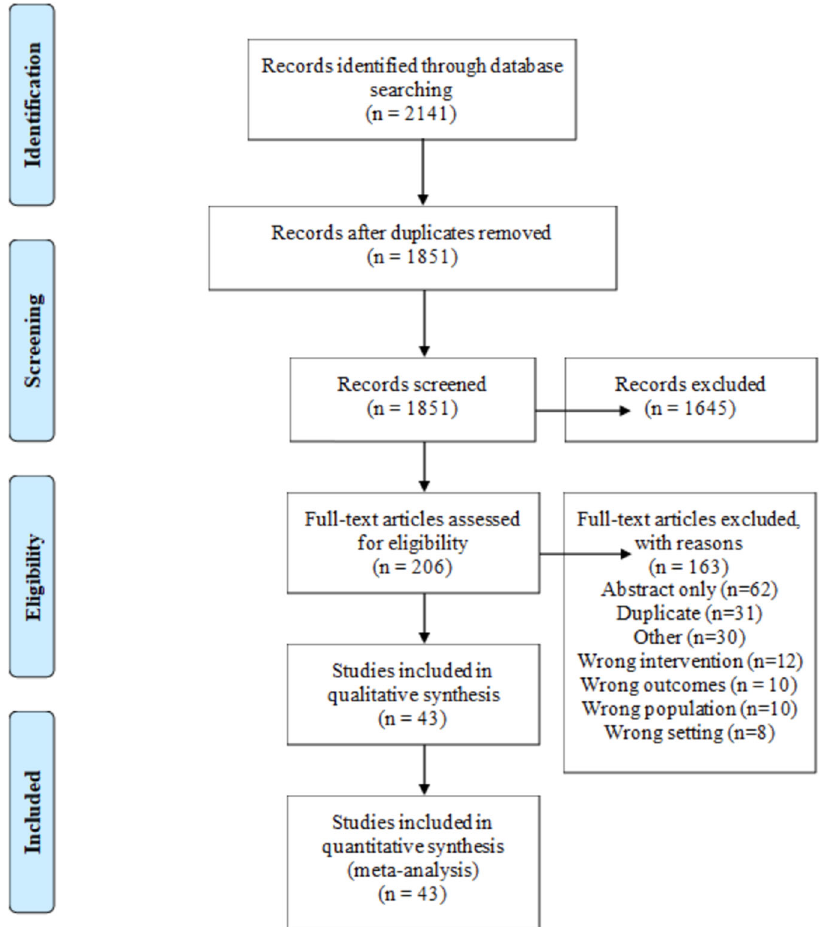
Fig. 1 PRISMA Flow